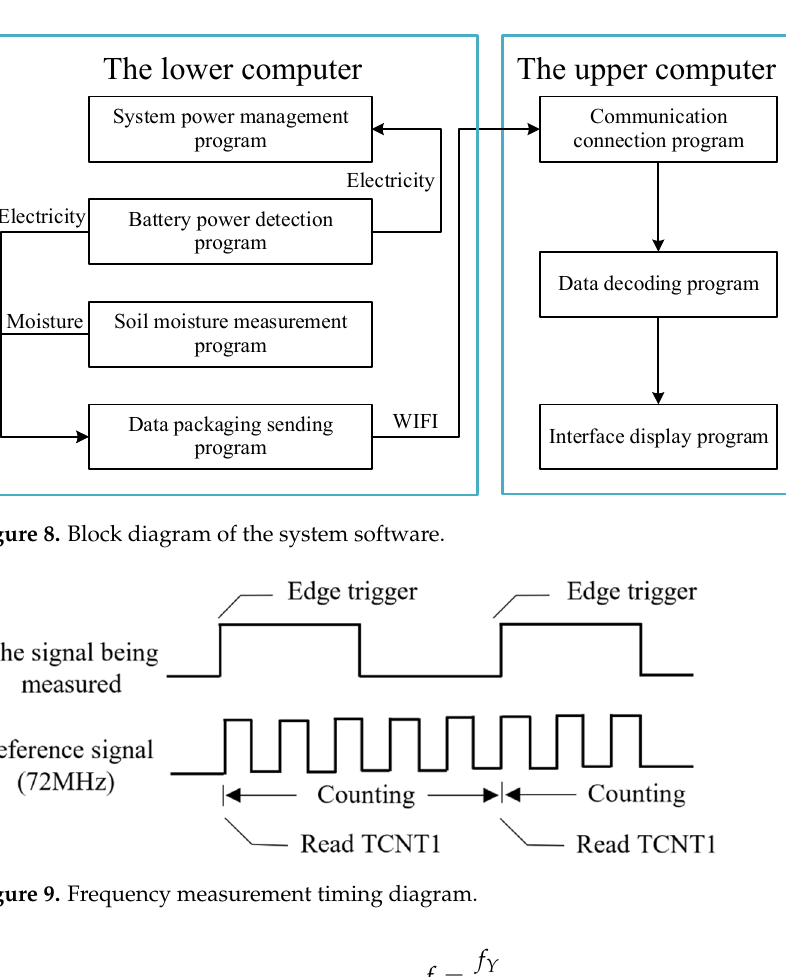
Figure 8. Block diagram of the system software .